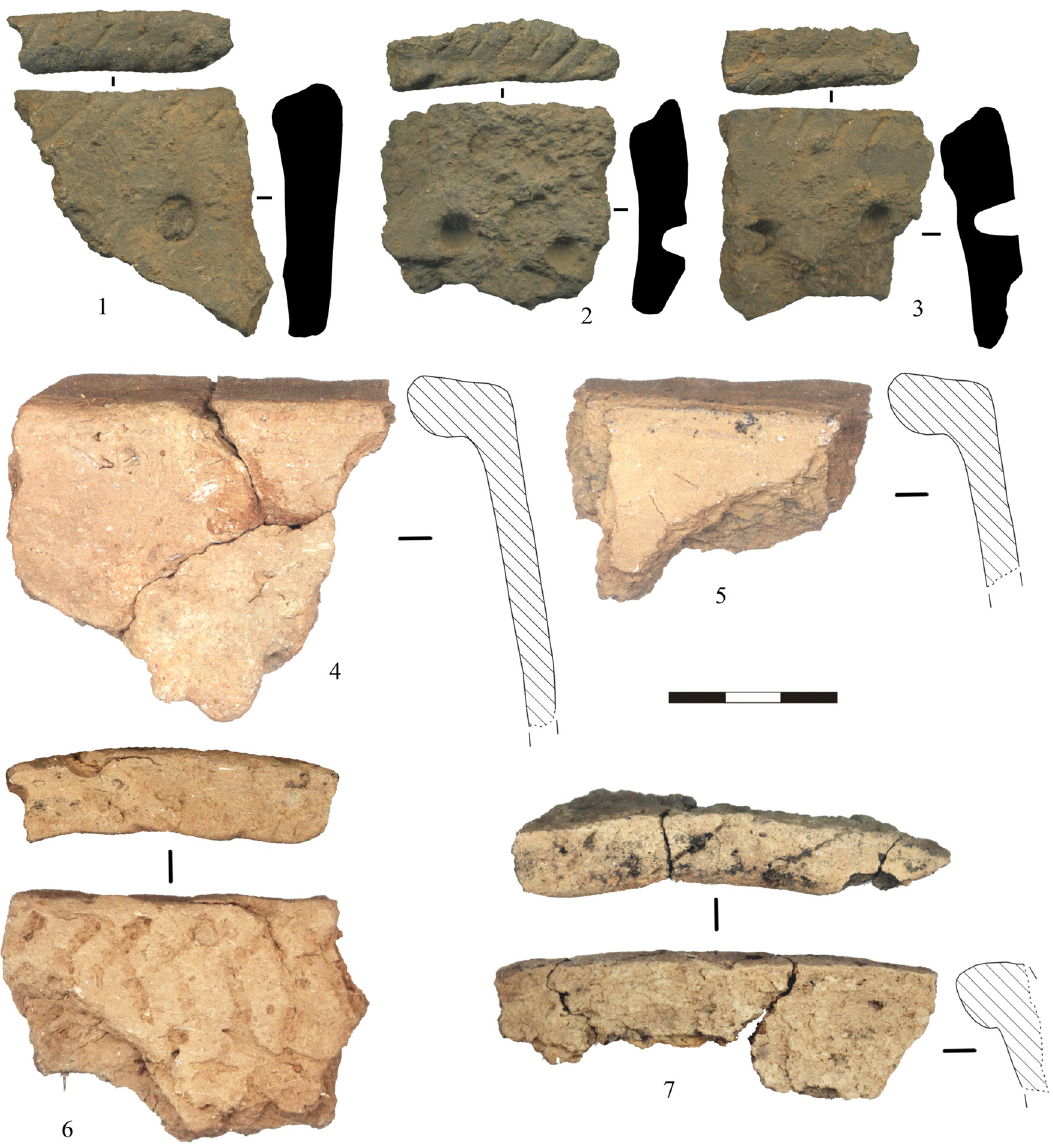
Figure 5: ( 1 – 3 ) Late Combed Ware, Narva - Luga Klint Bay area ( Izvoz 3, MAE RAS ) ; ( 4 – 7 ) Asbestos Ware ( Pöljä type ) , Karelian Isthmus ( Berezovo 2; MAE RAS )